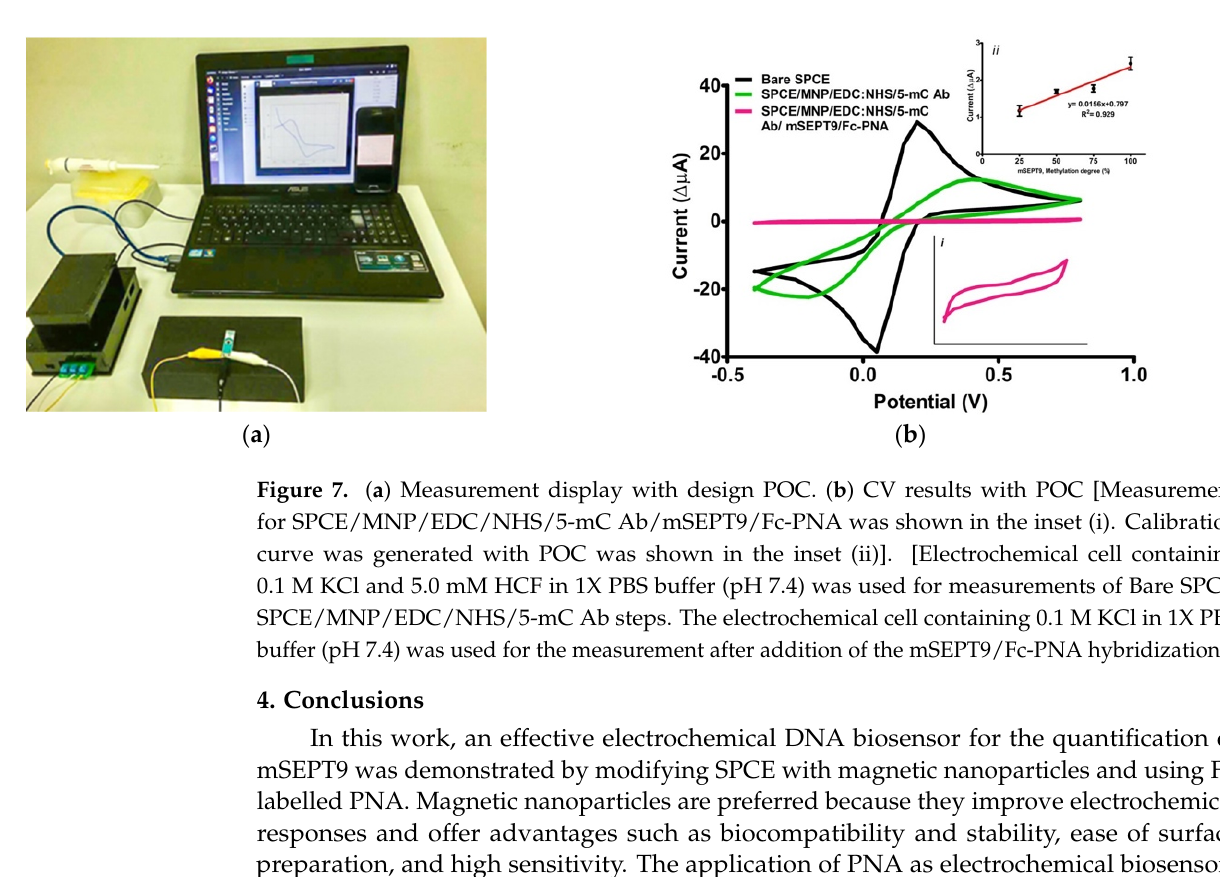
Table S3. Numerical data of CV and EIS measurements of biosensor; Scheme S1: Schematic depiction of the detection principle. Figure S9. Optimization steps of the proposed CRC diagnosis